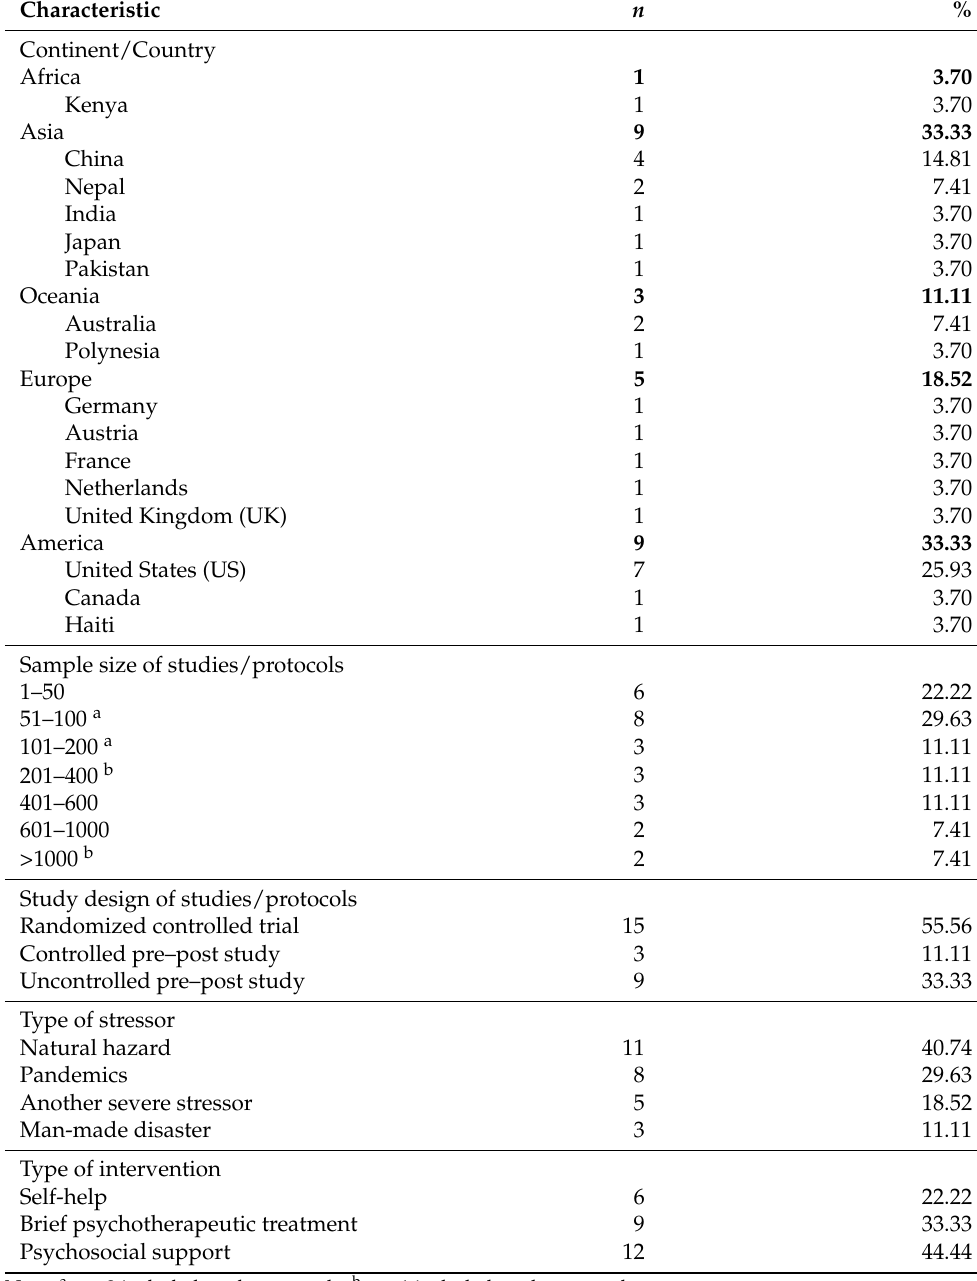
Table 1. Characteristics of the included published articles/protocols on brief interventions ( n = 27).